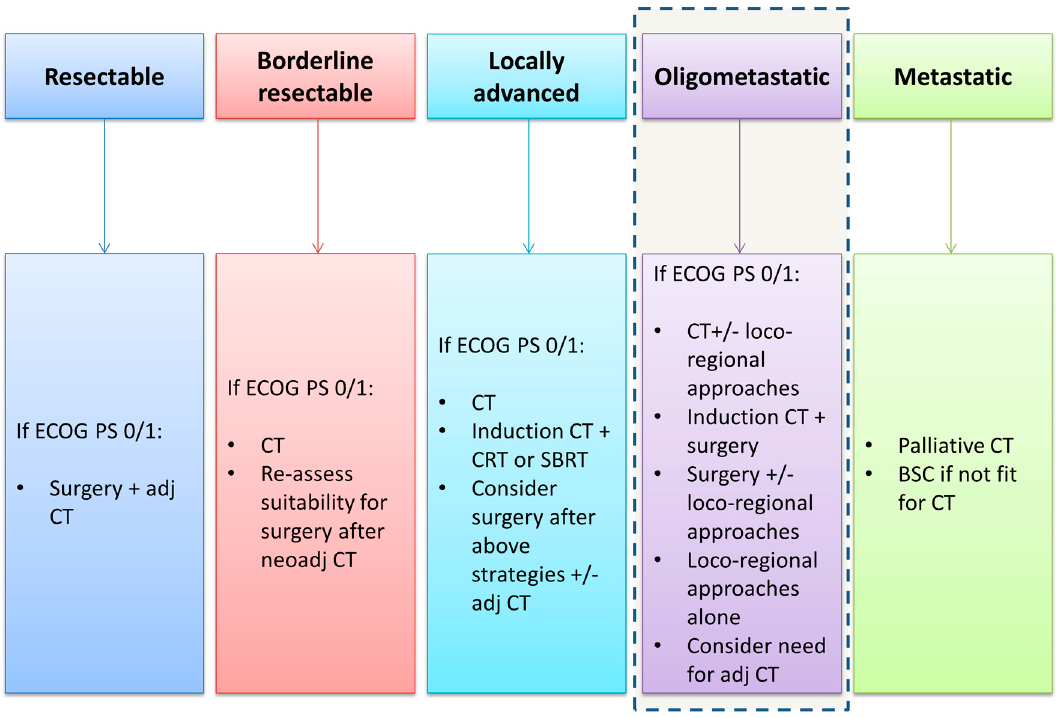
Figure 1. Initial treatment strategies for pancreatic cancer. Oligometastatic disease is not currently considered a separate entity in the treatment paradigm for pancreatic cancer but increasing evidence suggests that appropriately selected patients may be suitable for more intensified treatment strategies in high volume centers. ECOG PS: the Eastern Cooperative Oncology Group performance status; adj: adjuvant; CT: chemotherapy; BSC: best supportive care.